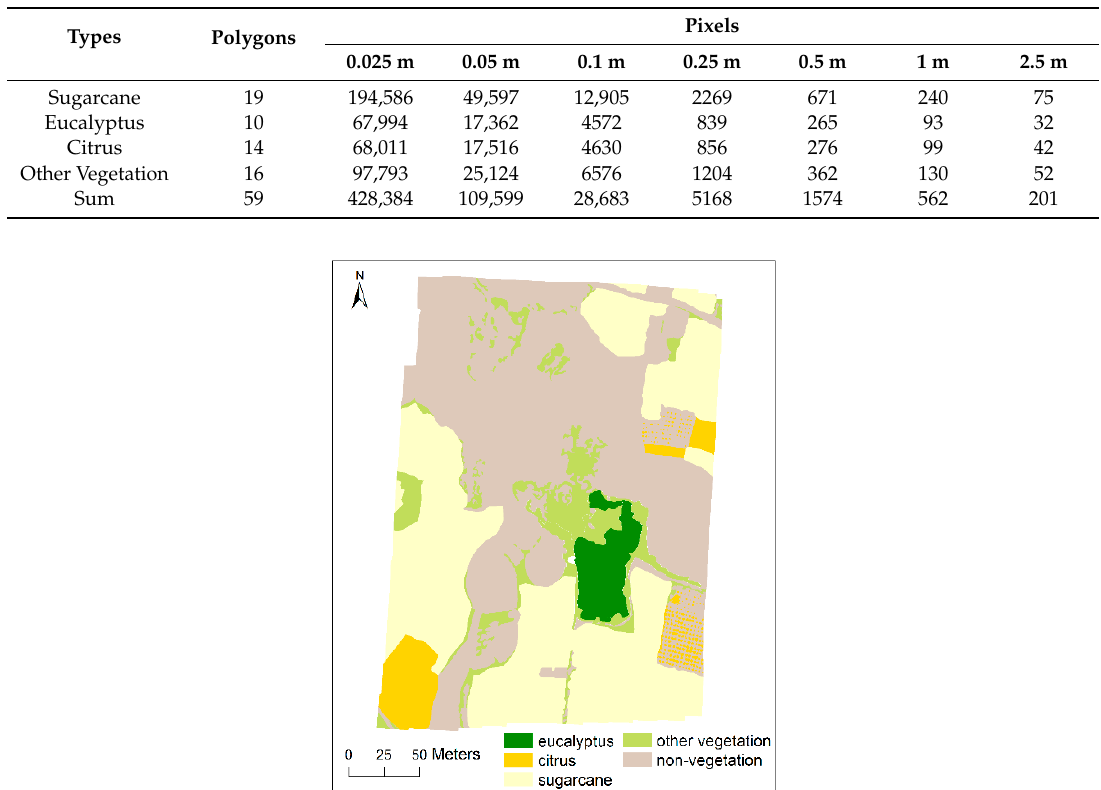
Table 1. A list of training polygons and corresponding pixels in multi-scale images.